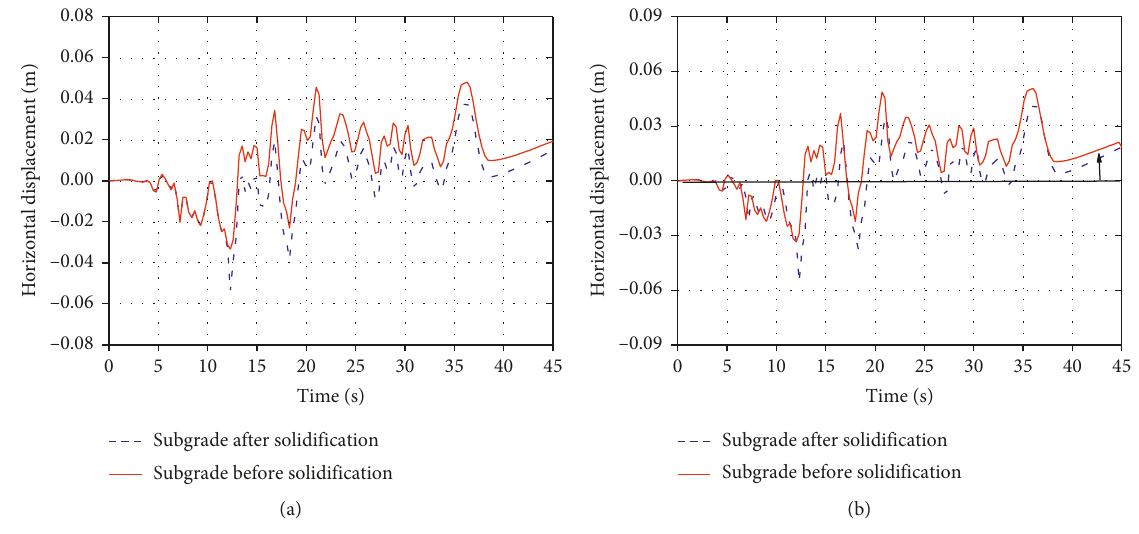
Figure 16: Displacement time histories of the right slope top and slope toe. (a) Slope top. (b) Slope